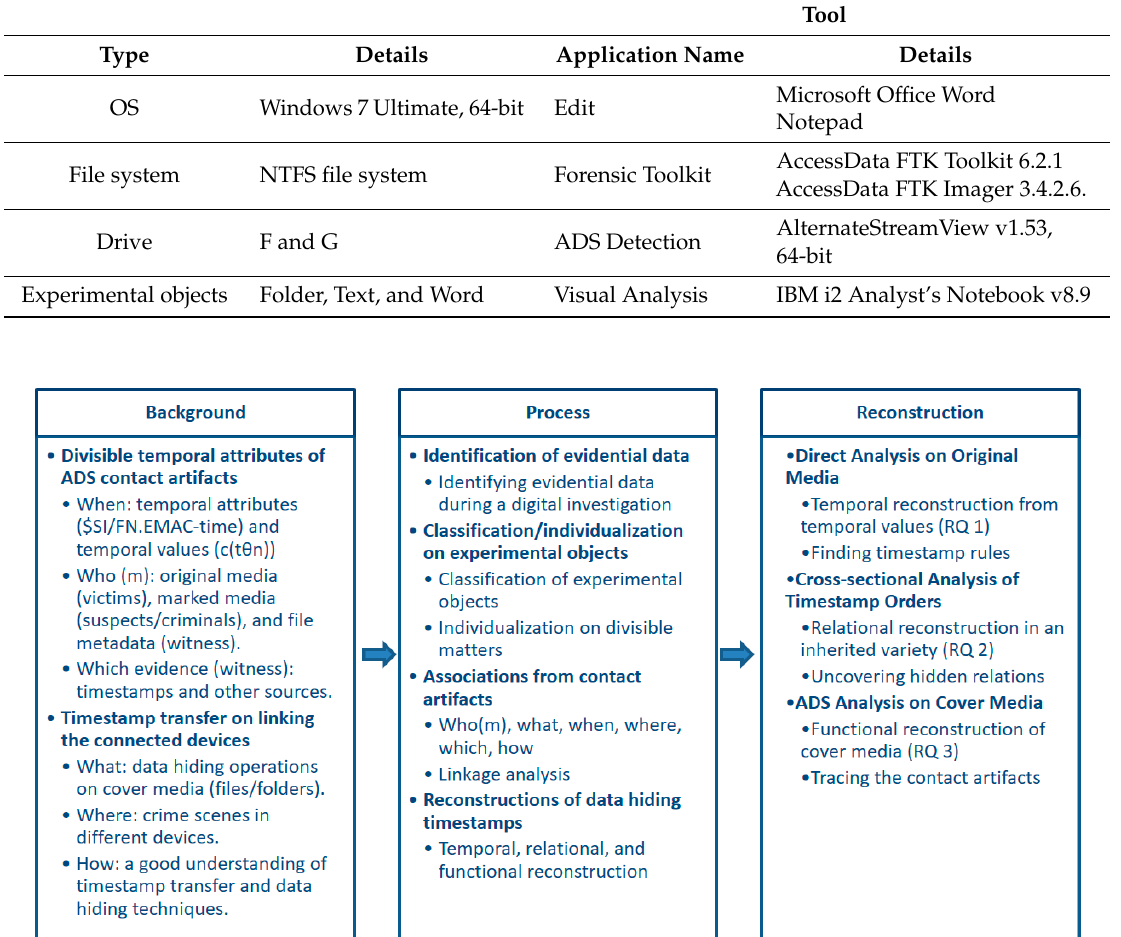
Table 4. Experimental environment.